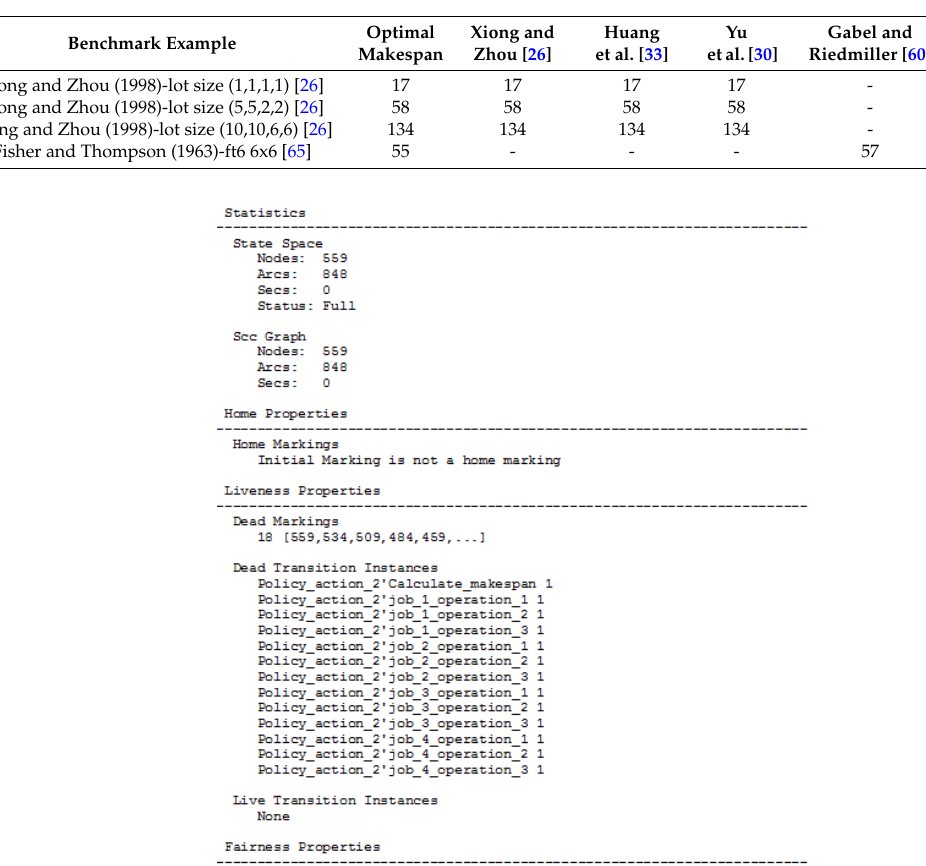
Table 4. Simulation comparison results for the makespan of job shop benchmark examples. The number in parentheses corresponds to the percentage of the scheduling agent Q-learning visits to the best obtained solution in 1000 cycles, i.e., in one simulation experiment.